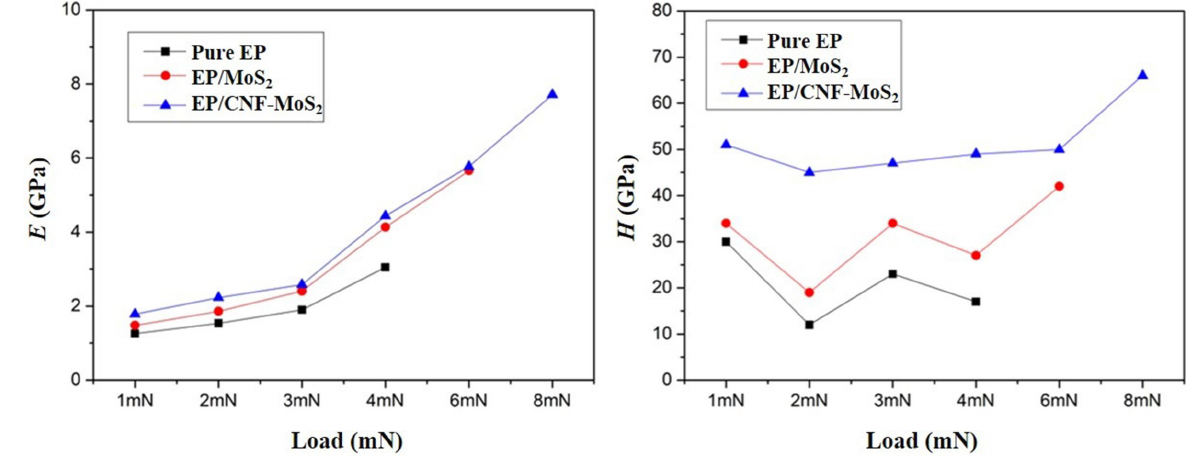
Figure 10: Variation of E and H at different indentation loads